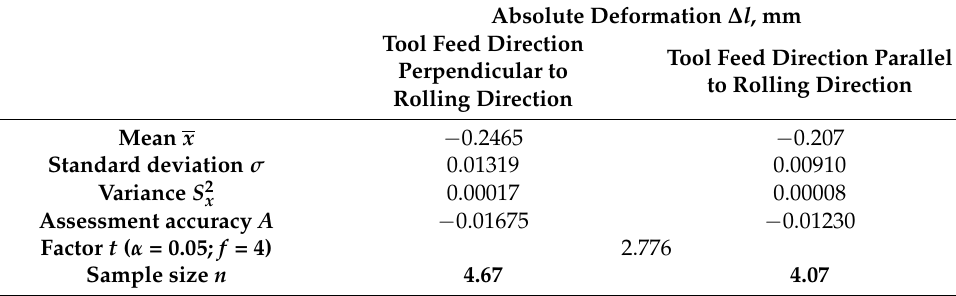
Table 6. Calculation of the sample size n in tensile